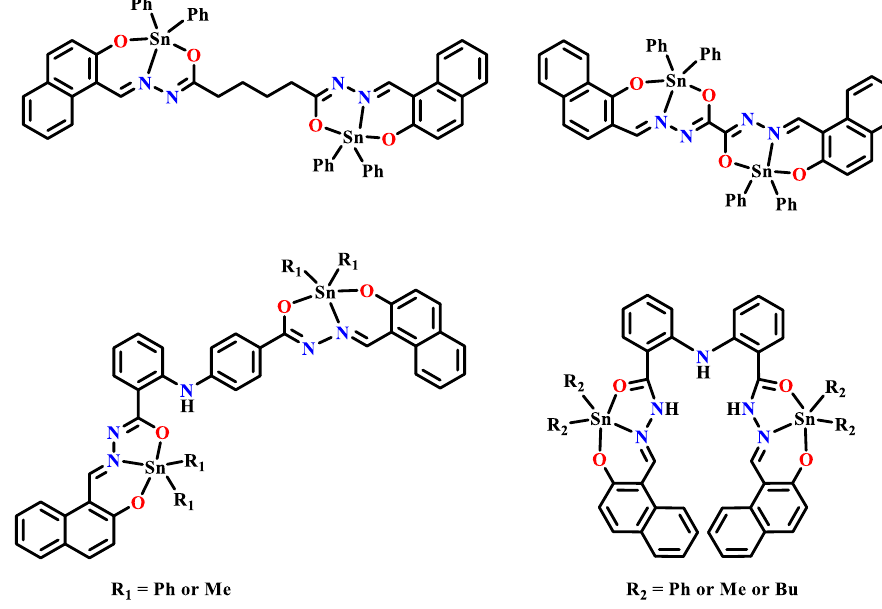
Figure 12. Isobinuclear organotin(IV) complexes based on dinaphthylhydrazone ligands.